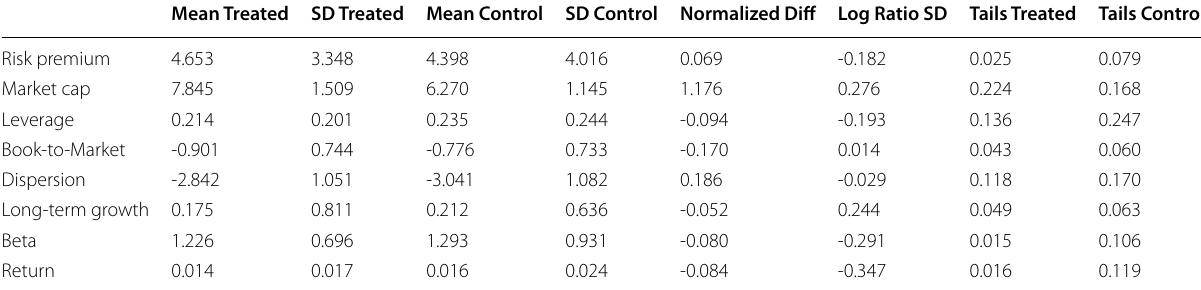
Columns 2-9 report results from the balance and overlap assessment of the treated and control samples: columns 6-7 report the normalized difference and the log ratio of the standard deviation, metrics for assessing the balance; and columns 8-9 report the fraction of observations in the tails of the opposing distribution, metrics for assessing the overlap